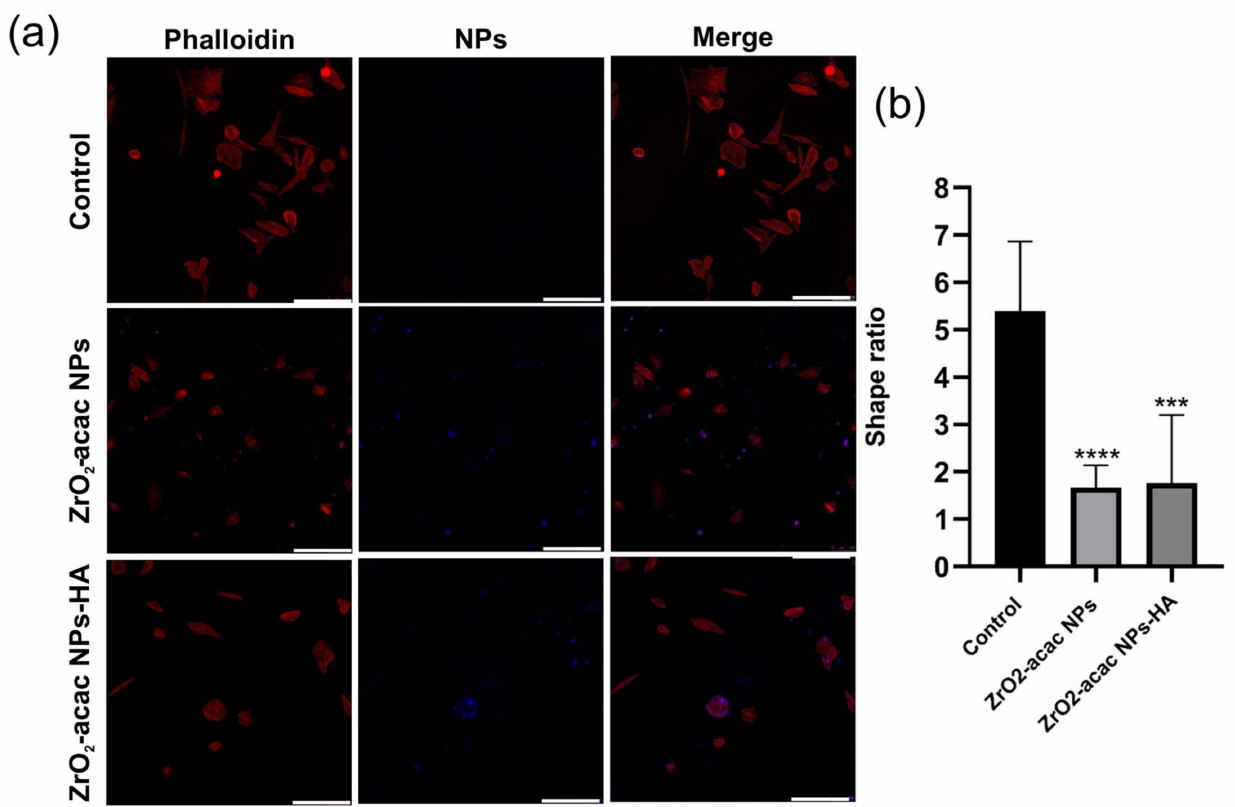
Figure 6. ( a ) Confocal analysis of SAOS-2 cells (red) incubated with ZrO 2 -acac NPs and ZrO 2 -acac NPs-HA (blue) for 48 h. Cell membranes were stained with red phalloidin. Both of the developed formulations interacted with cancer cells, altering their viability, as can be seen by changes in the SAOS-2 morphology and cell density. The scale bar is 250 µ m. ( b ) Cell shape index calculated by the image analysis of the SAOS-2 cells incubated with ZrO 2 -acac NPs and ZrO 2 -acac NPs-HA. The images are representative of four experiments. The level of significance was set at probabilities of *** p ≤ 0.0002 and **** p ≤ 0.0001 vs.